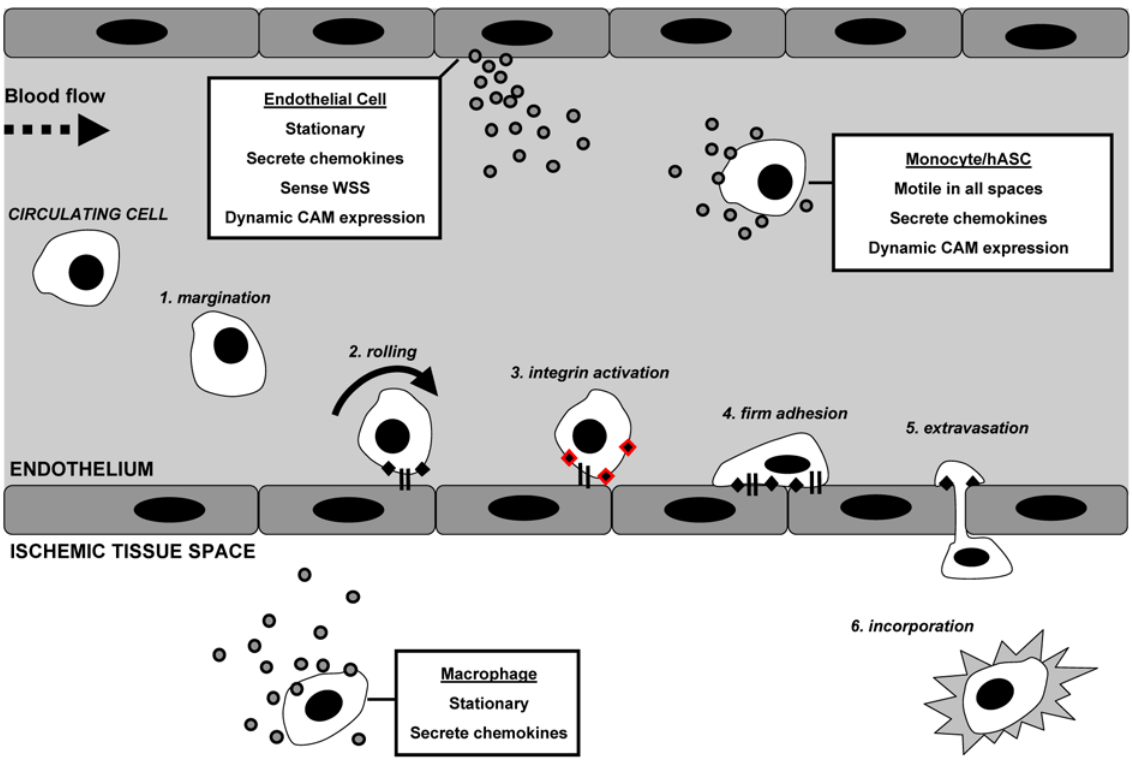
Figure 1. Graphical representation of the adhesion cascade during acute skeletal muscle ischemia, as instituted in the ABM. The adhesion cascade generally proceeds sequentially before incorporation, and is mediated by the interplay between adhesion molecule expression, chemokines and cytokines, hemodynamics, and survey behavior. Interactions are complex spatially and temporally, and cell phenotypes accounted for within simulations are tissue macrophages, endothelial cells making up the blood vessel wall, circulating monocytes, and circulating human adipose-derived stromal cells.